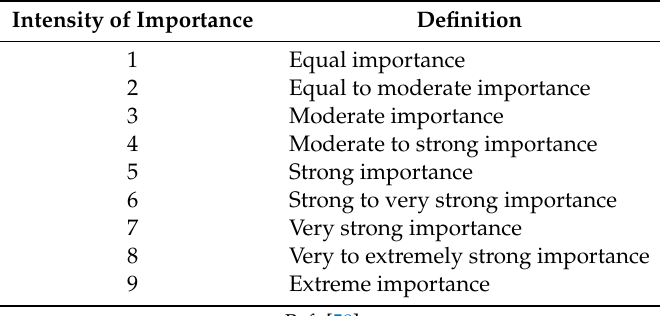
Table 2. Scale for pairwise